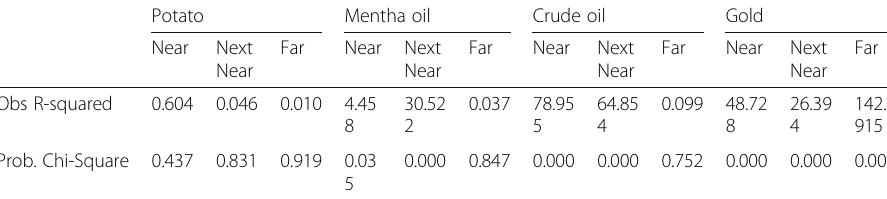
Table 7 Result of ARCH-LM test for residuals Potato Mentha oil Crude oil Gold Near Next Far Near Next Far Near Next Far Near Next Near Near Near Near